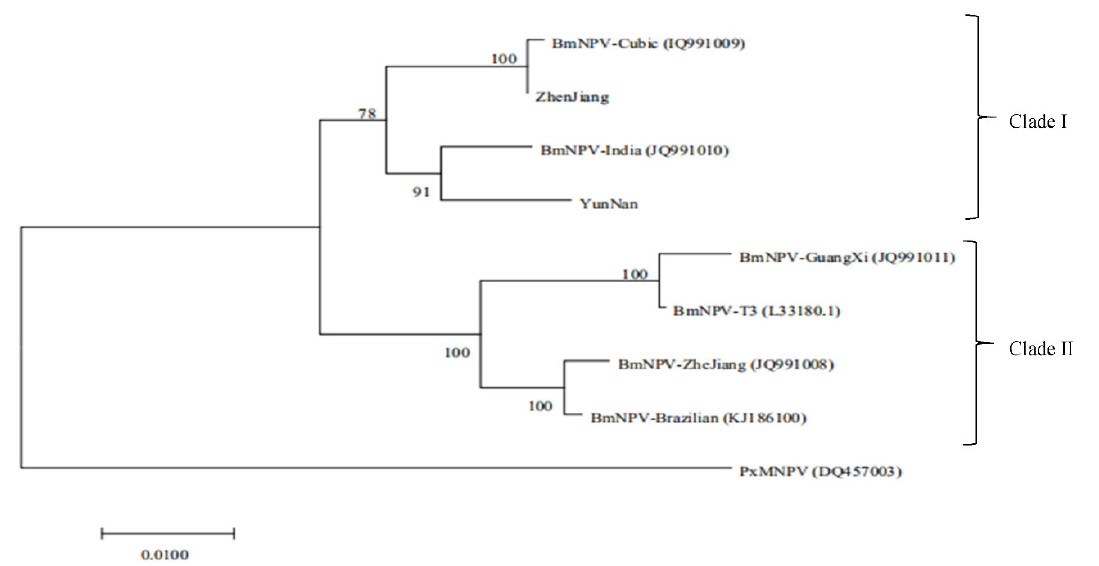
Figure 5. Phylogenetic tree constructed based on bro-d gene sequences of BmNPV isolates.